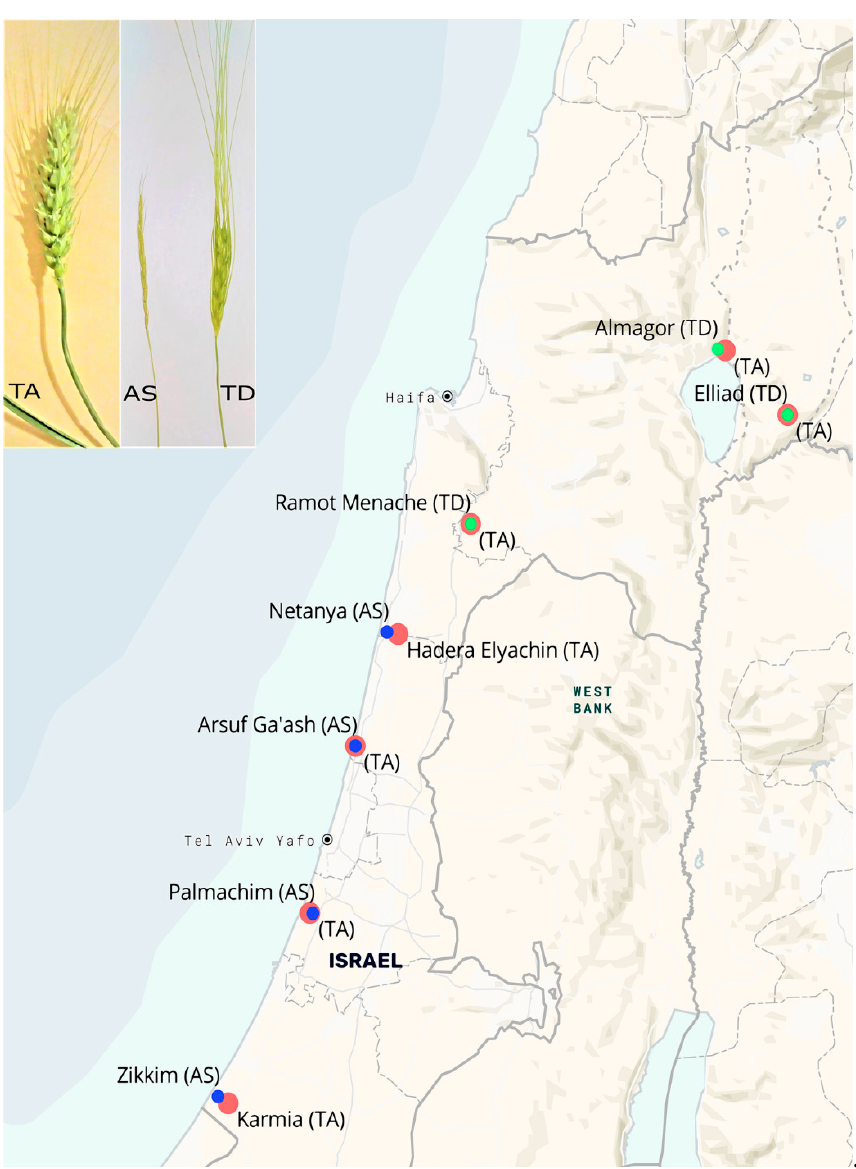
Figure 1. Collection sites of Triticum aestivum (TA, wheat), Aegilops sharonensis (AS, sharon goatgrass) and Triticum dicoccoides (TD, wild wheat). A. sharonensis is an endemic species that grows only in a specific region along the Mediterranean coast of Israel, T. dicoccoides grows in specific habitats in the northern parts of the country. Locations of paired sampling: TA/AS—blue circles, TA/TD—red circles. Sample preparation . Plants were uprooted with soil, placed in a 4 °C container, and processed within 24 h. Stems segments were cut, surface-sterilized by submerging in 0.5% commercial bleach for 2 min, and washed by dipping three times in sterilized distilled water. The sterilized stem samples were cut into five mm pieces, and 150 mg samples that included pieces from each intermodal segment were placed in Eppendorf tubes, snap frozen in liquid nitrogen, and stored at − 80 °C freezer.